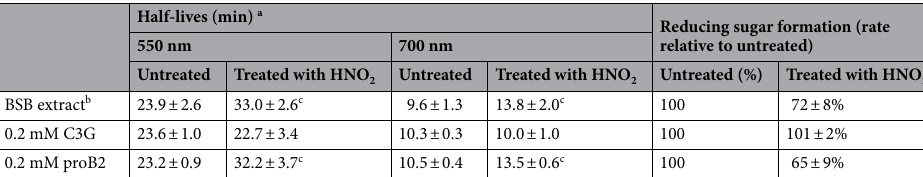
Table 2. Effects of nitrous acid-treatment on pancreatin-induced hydrolysis of amylose heated with BSB extract, C3G, or proB2. a The values were determined as Fig. 1 b Concentration of C3G in BSB extract, 0.2 mM. c Significant difference between “Untreated” and “Treated with HNO 2 ”. p < 0.05 (n =